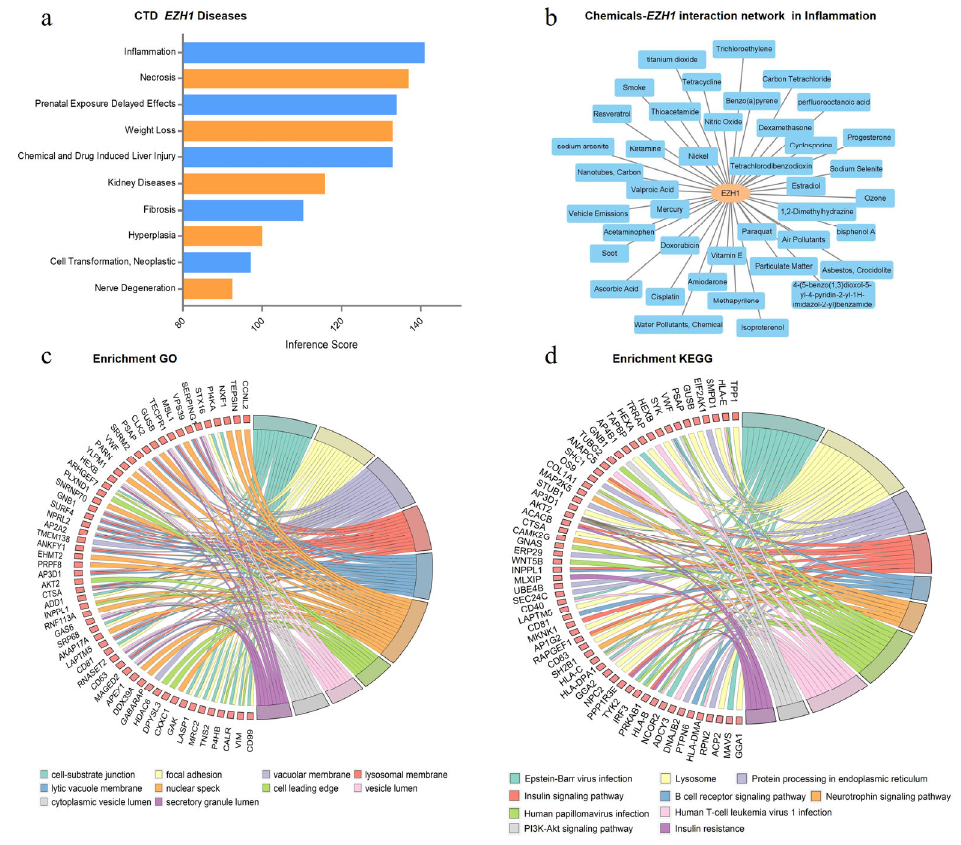
Figure 5. Functional annotation of EZH1 . ( a ) Disease categories associated with EZH1 gene in the CTD database with inference scores. ( b ) A total of 41 chemicals interacted with EZH1 and correlated with inflammation. Circle diagrams of GO ( c ) and KEGG ( d ) enriched pathways for genes co-expressed with EZH1 from GSE16134. CTD, the Comparative Toxicogenomics Database; GO, Gene Ontology; KEGG, Kyoto Encyclopedia of Genes and Genomes.